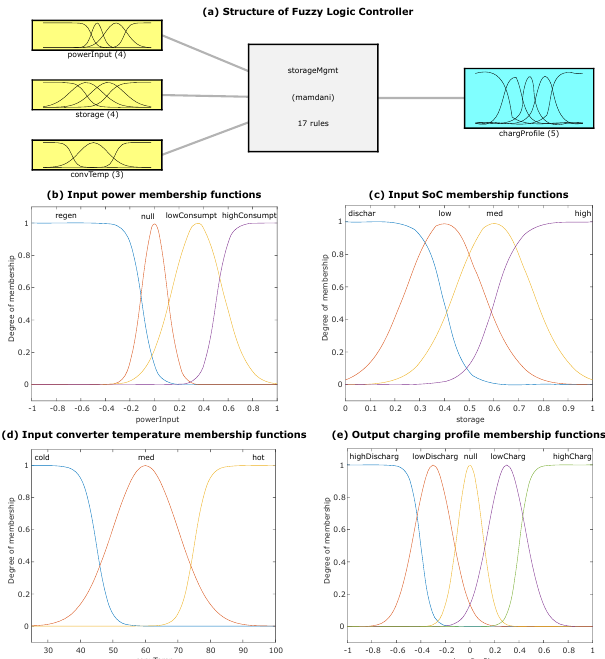
Figure 5. Implemented fuzzy logic controller: (a) Structure of controller; (b) MF of train power consumption input variable; (c) MF of ESS state of charge input variable; (d) MF of converter temperature input variable; (e) MF of charging percentage of the ESS output variable.